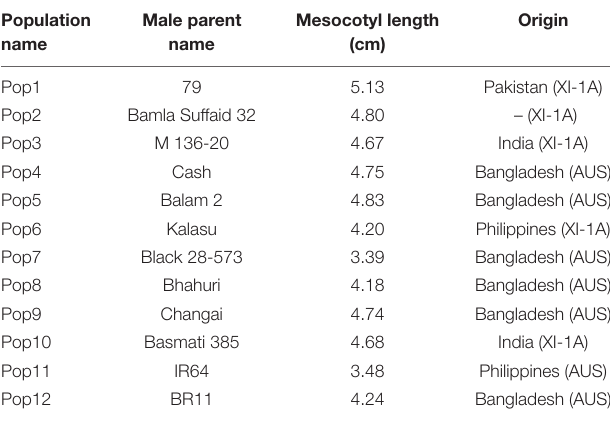
TABLE 1 | Details of the male parents of the 12 F 2